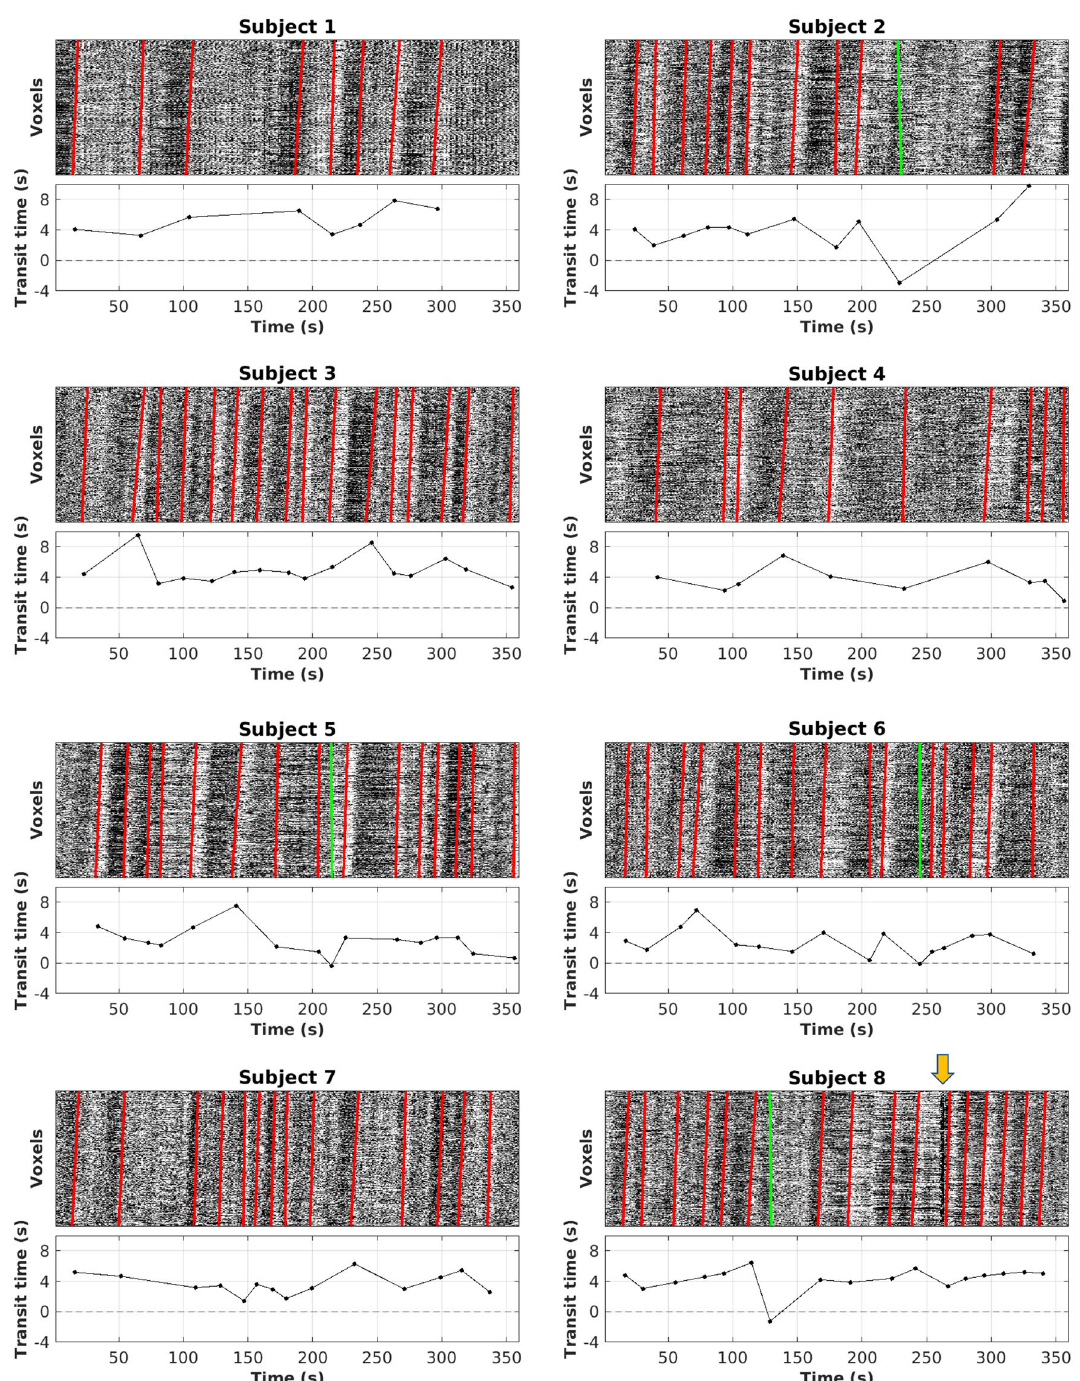
Figure 4. Illustration of the dynamic change in transit time during the rs-fMRI scan for all subjects. For each subject, the rs-fMRI SHAG carpet plot with identified edges is shown on the top, while a plot showing the dynamic change of the transit time of each identified edge is shown on the bottom. Negative transit times indicate an edge sloped in the opposite direction relative to the majority of edges identified; such edges are marked with a green line. Note that for subject 8, we identified a mostly vertical sudden intensity change by the yellow arrow, representing a motion